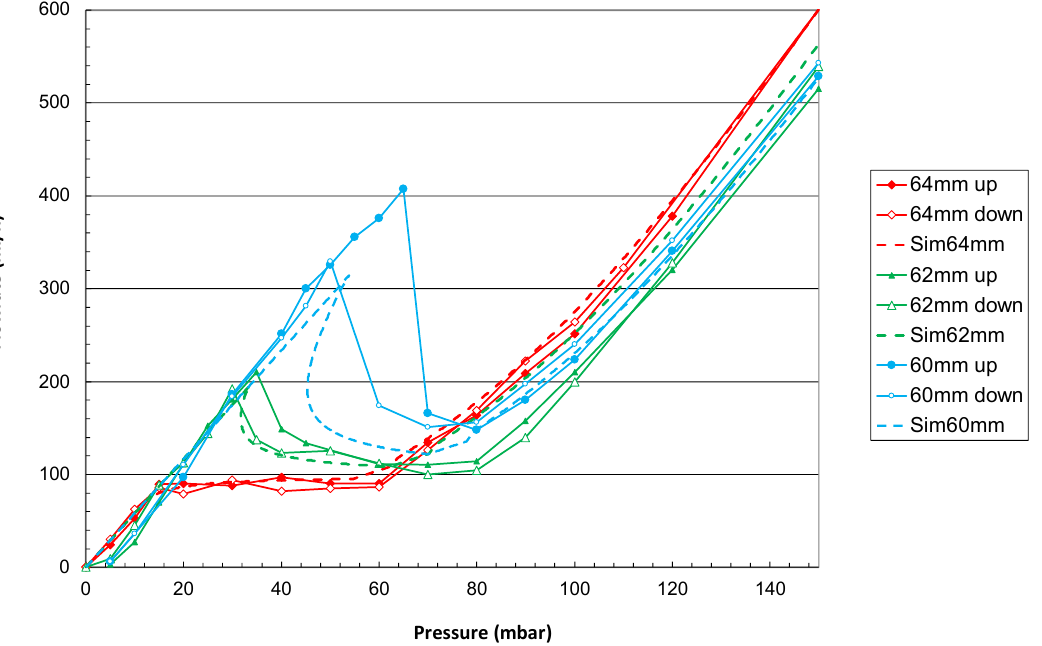
Figure 10. Flow rate versus pressure characteristics of the valve for the three different settings 0, 1, and 2 (corresponding to a flange-to-flange distance of, respectively, 64, 62, and 60 mm) using positive (up) and negative (down) pressure steps. The valve is tested vertically, with the inlet above the outlet. Dashed lines represent the numerical simulations of the valve for each setting.